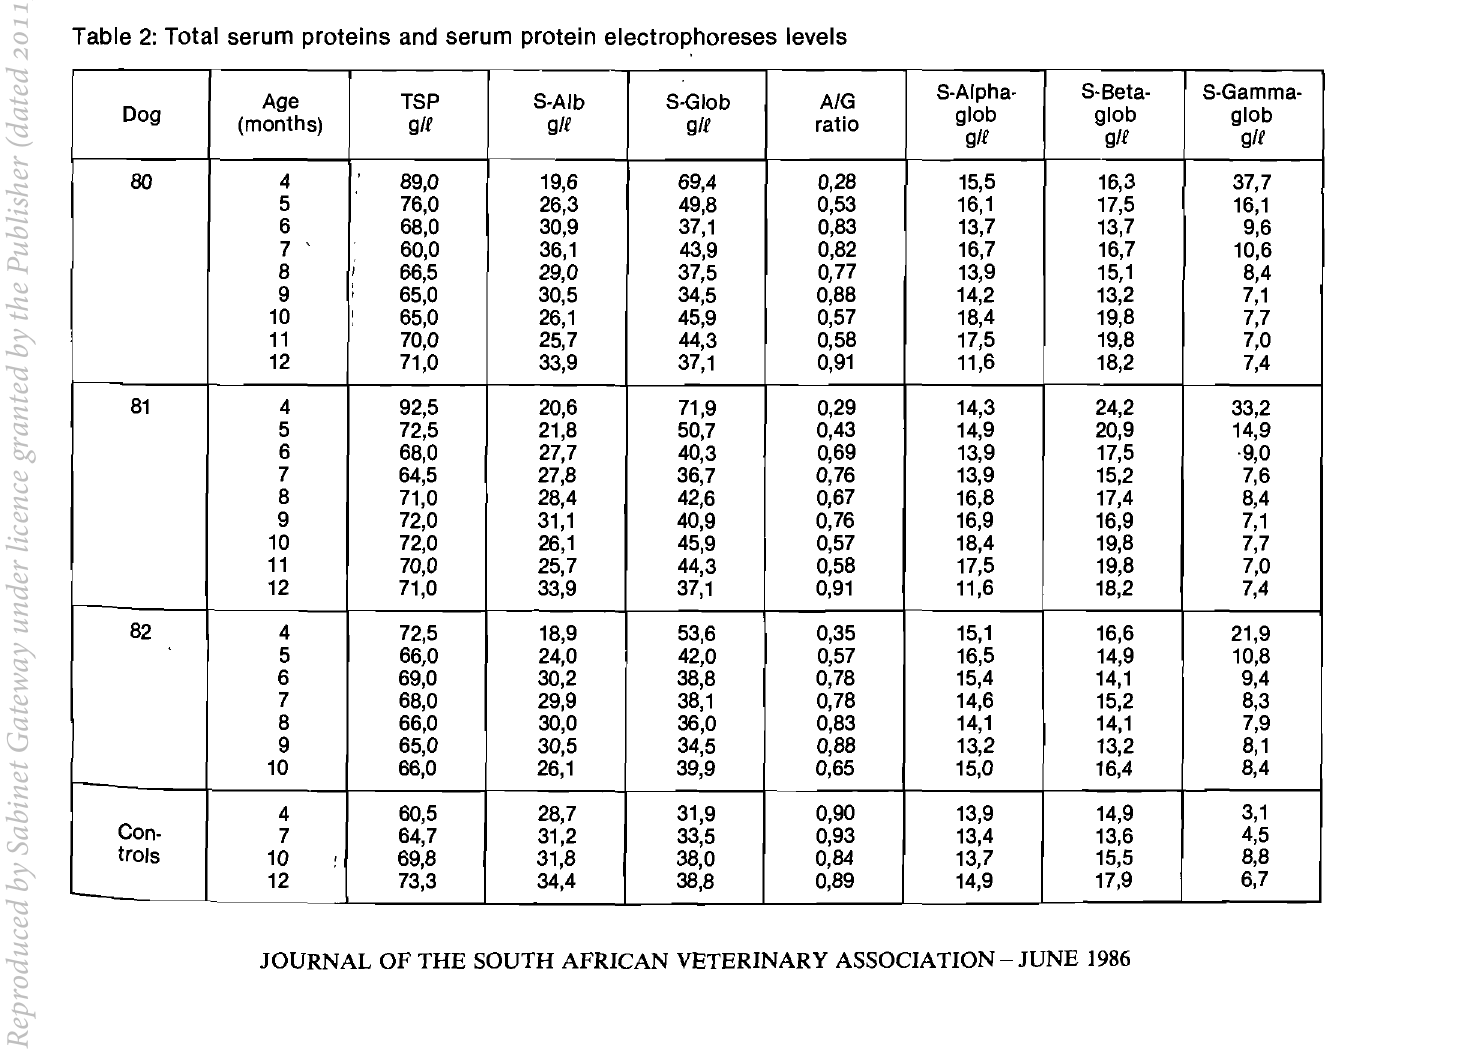
pear from the kidneys (TYz) as obtained for each of the 3 dogs and each study, are tabulated in Table 4. Figs. 9 & 10 represent radiorenograms of two dogs (Dogs 80 and 81, respectively). The changes in kidney function which had occurred during the 3 months be tween the first (A) and second (B) studies can clearly be seen. Note that there were instances where the radiorenographic study did not run for the full time. This was due to movement of the dog which invalidated the remainder of the study. Fig. 11 (A - D) depicts the DMSA scans of the kidneys of Dogs 80 and 81 taken for each with a 3